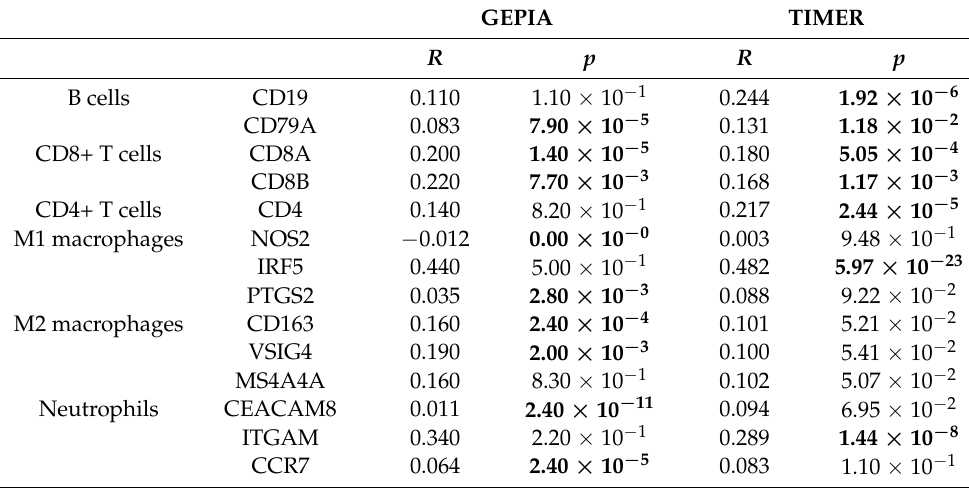
Table 2. Correlation analysis between EZH2 and biomarkers of immune cells in HCC determined using the GEPIA and TIMER